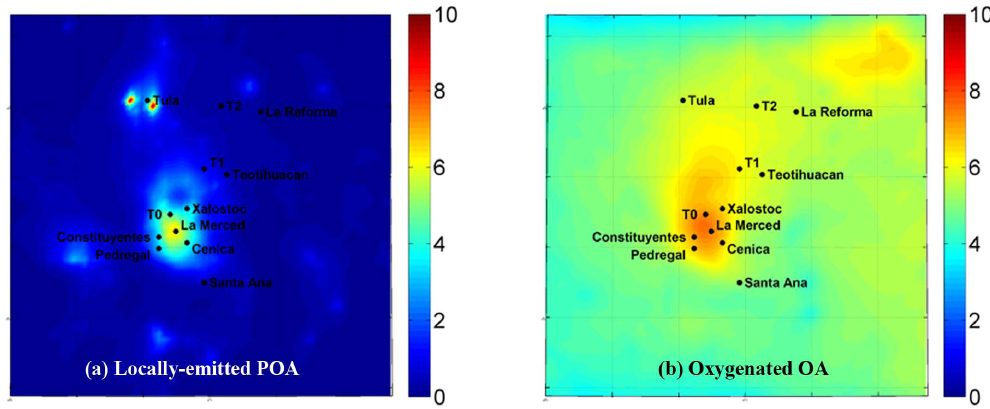
Fig. 3. Average predicted PM 1 (a) primary and (b) oxygenated organic aerosol concentrations (µgm − 3 ) at the ground